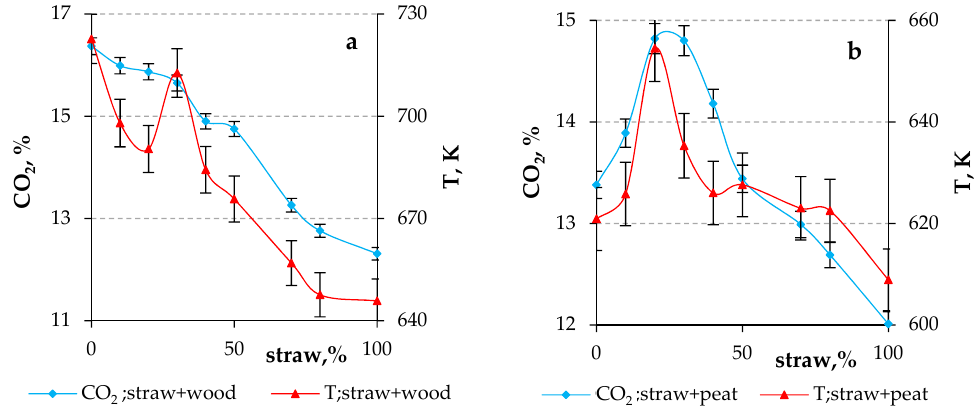
Figure 5. Effect of the straw mass share wt.% on the CO 2 volume fraction in the products and on the flue gas temperature when co-firing straw with wood ( a ) or with peat ( b ).